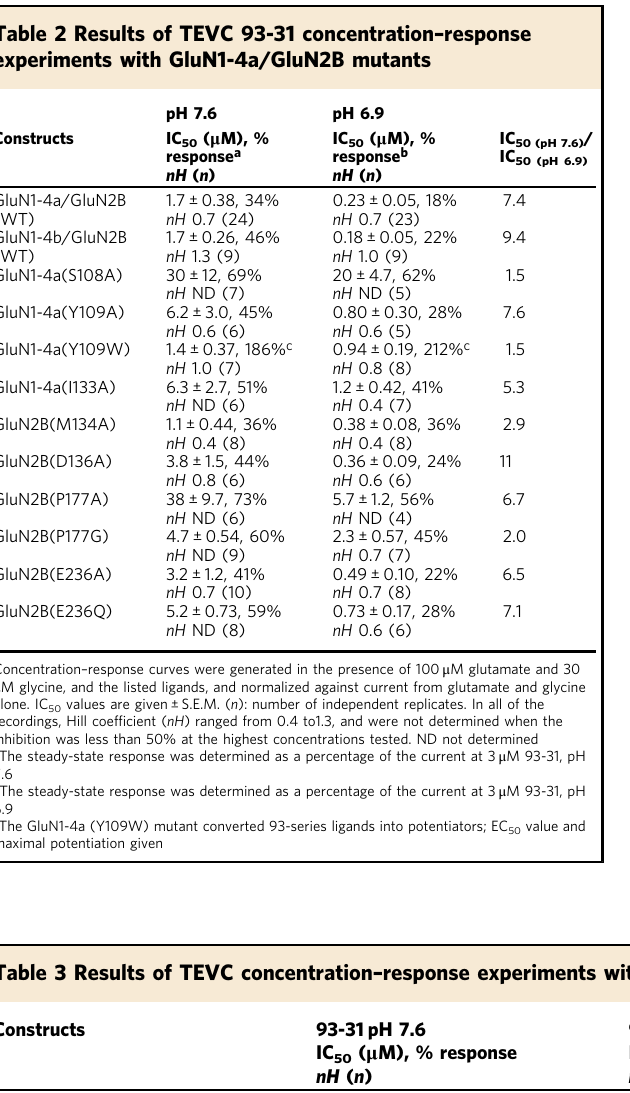
Table 2 Results of TEVC 93-31 concentration – response